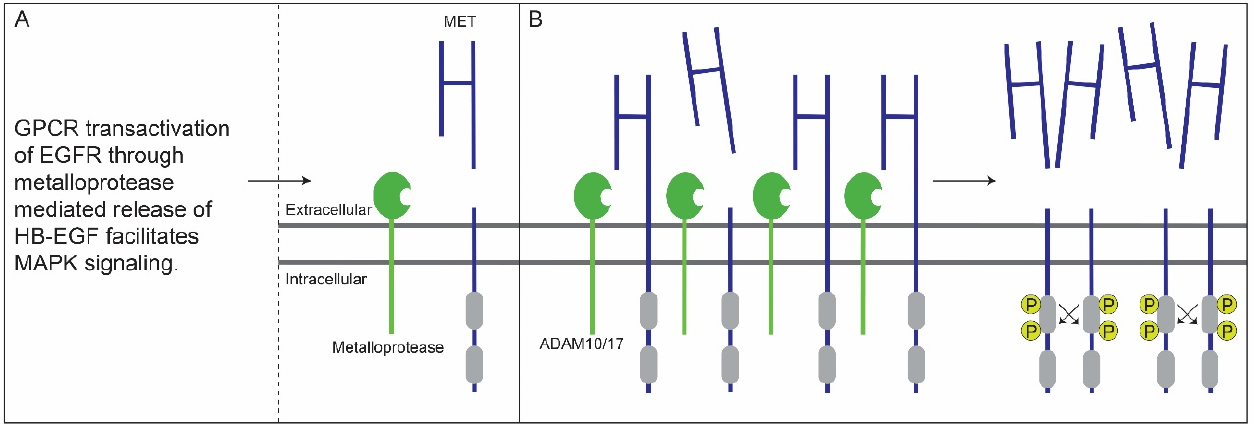
Figure 2. Crosstalk between G-protein-coupled and EGF receptors enhances MET ectodomain shedding. ( A ) GPCR transactivation of EGFR through metalloprotease mediated release of HB-EGF enables MAPK signaling, ultimately resulting in MET ectodomain shedding, which is also facilitated by metalloproteases. ( B ) Overexpression of ADAM10/17 and/or MET in OSCC will result in the increased concentration of MET-EC - fragments on the tumor cell membrane thus facilitating stabilization (e.g., by dimerization or oligomerization) and constitutive activation of MET-EC - . This figure and its legend, specifically 2A, was inspired by Figure 1 and its legend by Gschwind et al.